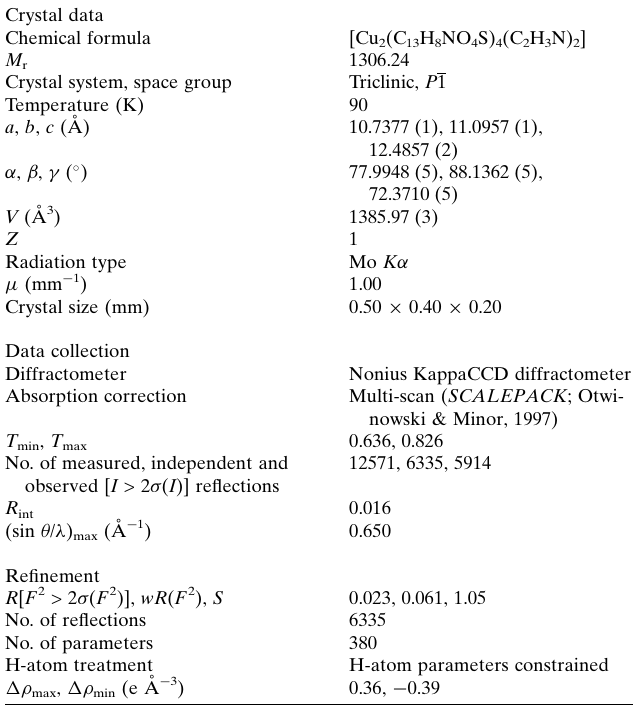
Crystal data Chemical